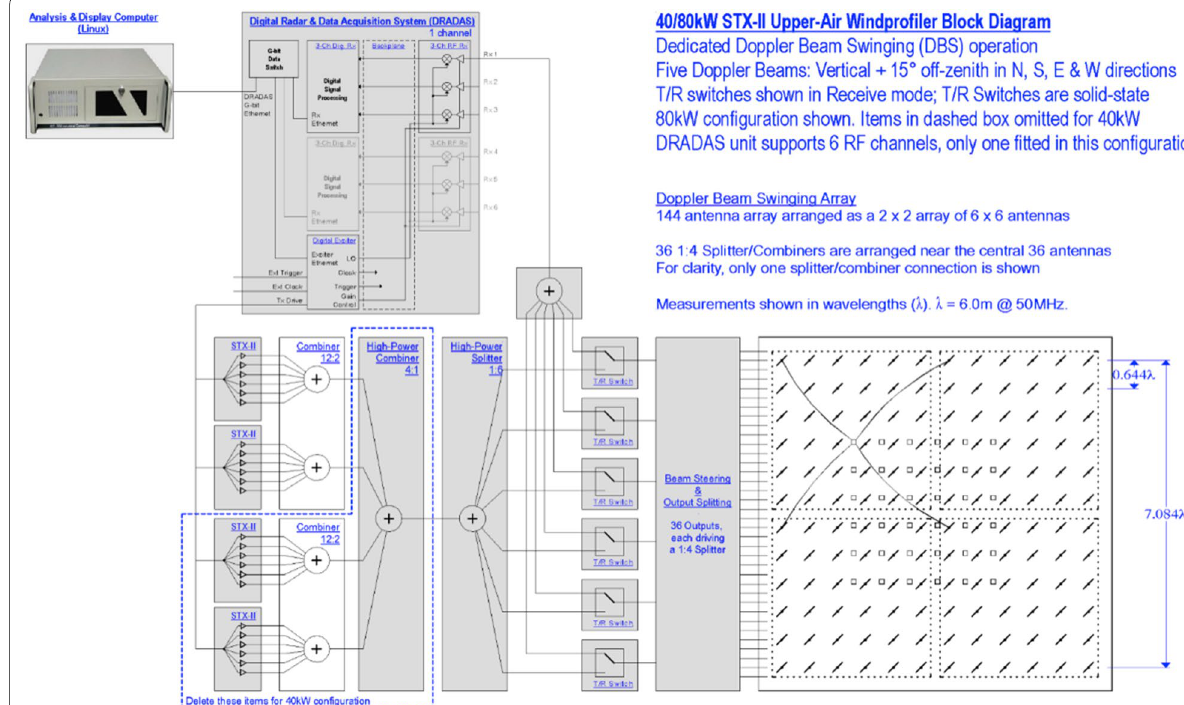
Fig. 2 Schematic of the ST profiler. The operational systems use the 80 kW configuration, while the BP ST radar discussed in the text uses the 40 kW configuration. See text for a fuller